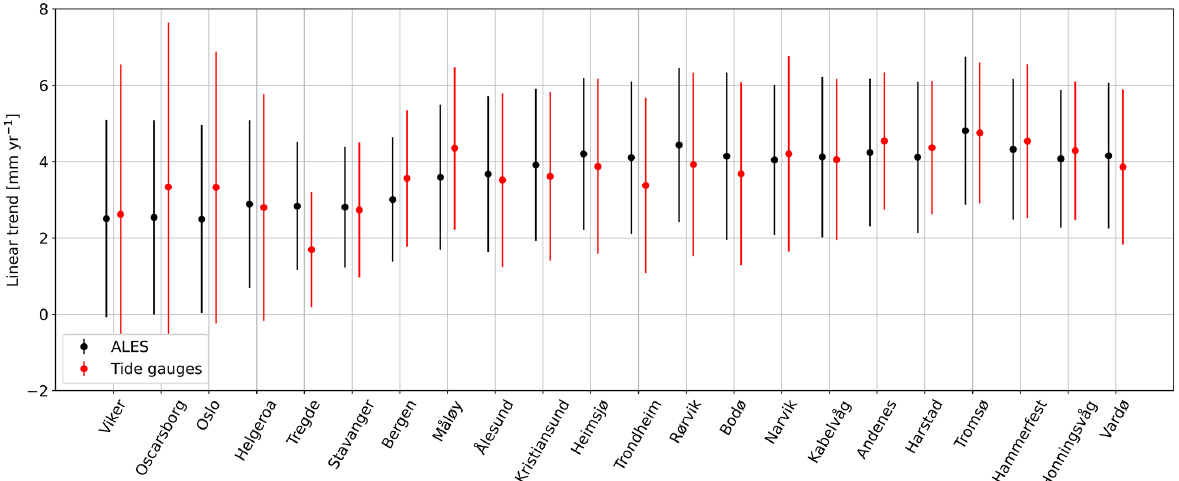
Figure 9. At each tide-gauge location, the linear trend of the SLA from the ALES-reprocessed altimetry dataset (black dots) and from tide gauges (red dots). The error bars show the 95th confidence intervals of the sea-level trend at each tide-gauge location.